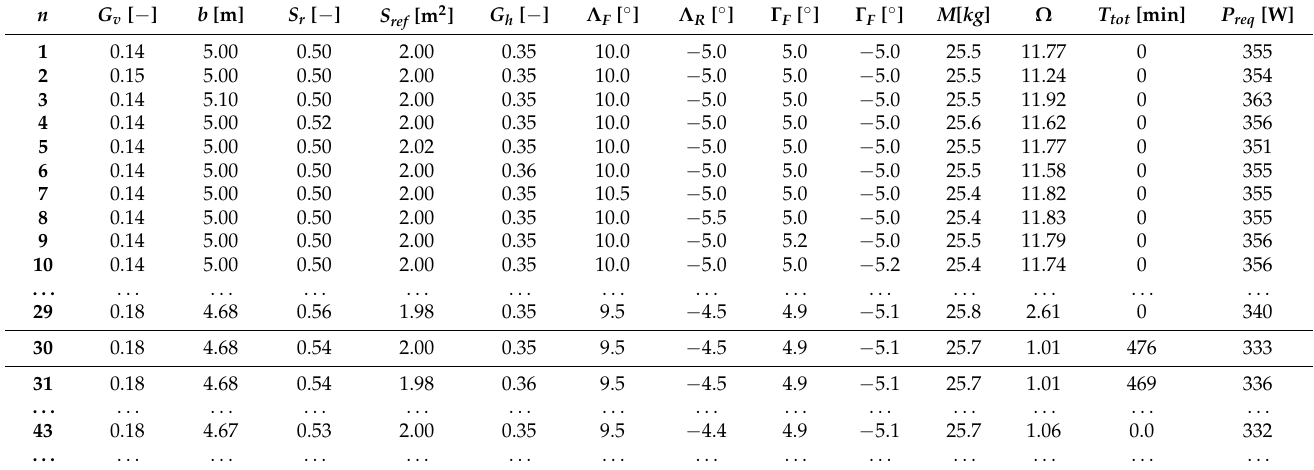
Table 4. Excerpt from the database evaluated configuration for the box-wing UAV